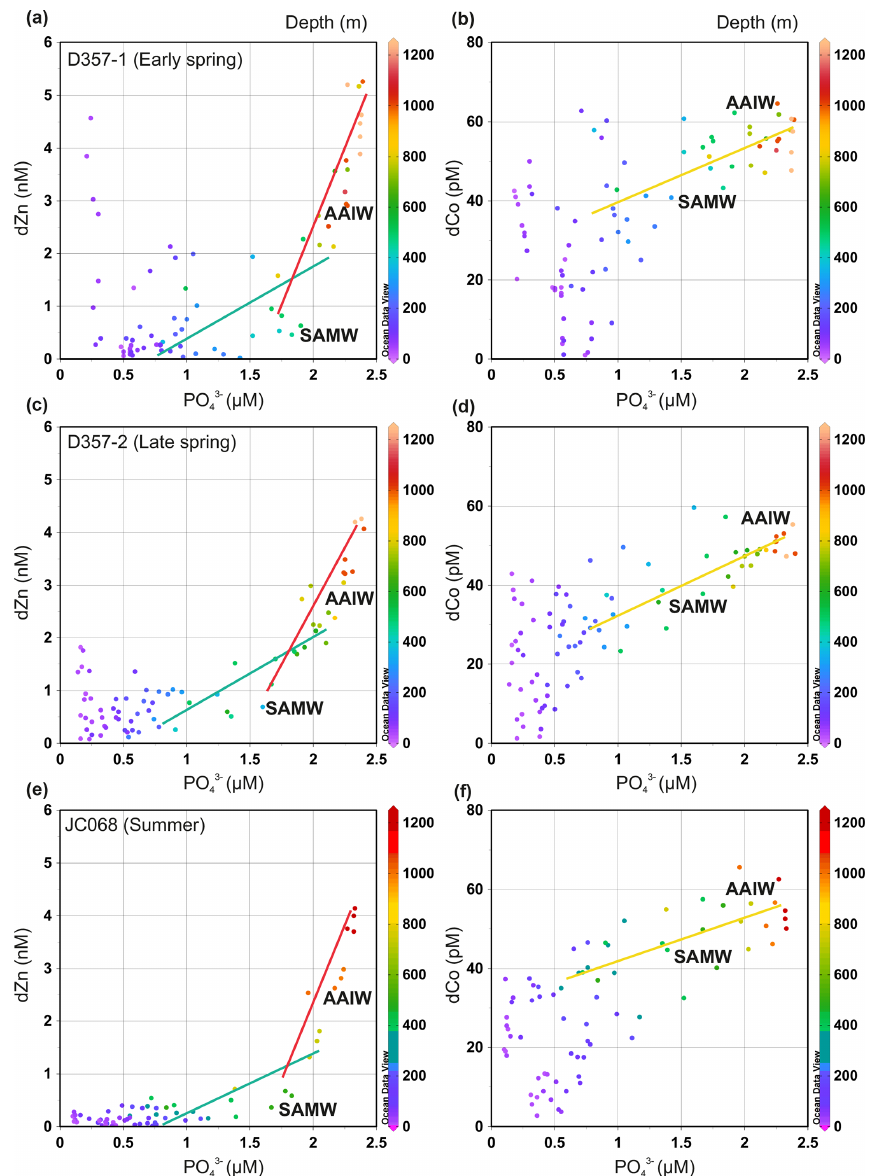
Figure 4. The dissolved Zn and Co versus PO 3 − distribution for the south-eastern Atlantic during early-spring ( a, b ; D357-1), late-spring ( c, 4 d ; D357-2) and summer ( e, f ; JCO68) transects. The green and red lines indicate the dZn:PO 3 − regression slopes for SAMW and AAIW, 4 respectively. The yellow line indicates the dCo:PO 3 − regression slope for SAMW and AAIW combined. The equations for regression lines 4 are detailed in Supplement Table S1. SAMW: sub-Antarctic mode water; AAIW: Antarctic intermediate water. The full depth dZn:PO 3 − 4 relationship along JC068 can be found in Wyatt et al.